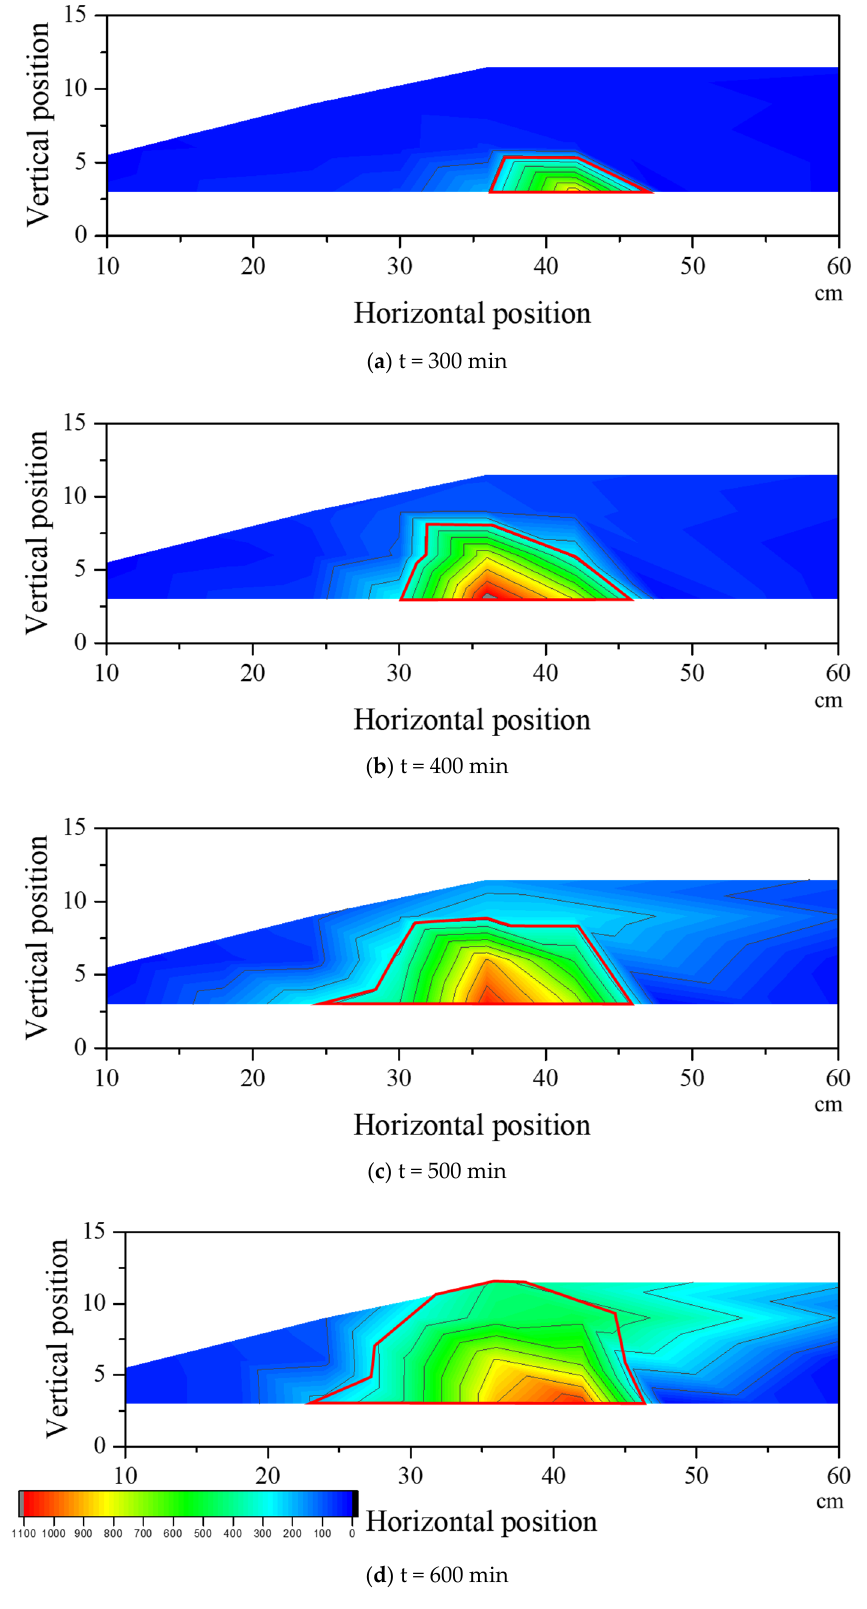
Figure 7. Temperature field and cavity shape at different stages. In accordance with the shape diagram of the cross-section, the high-temperature zone above the ignition point expands rapidly. An arc-shaped gasification cavity is formed.